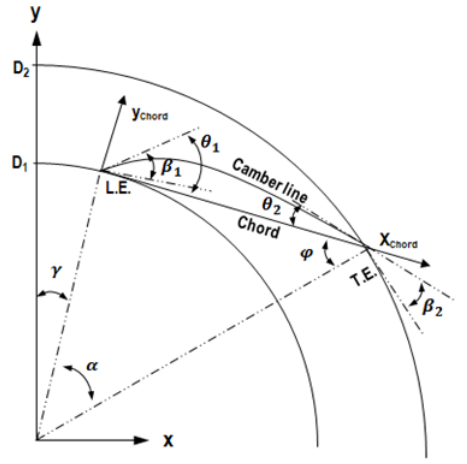
Figure 7. Airfoil design parameters.